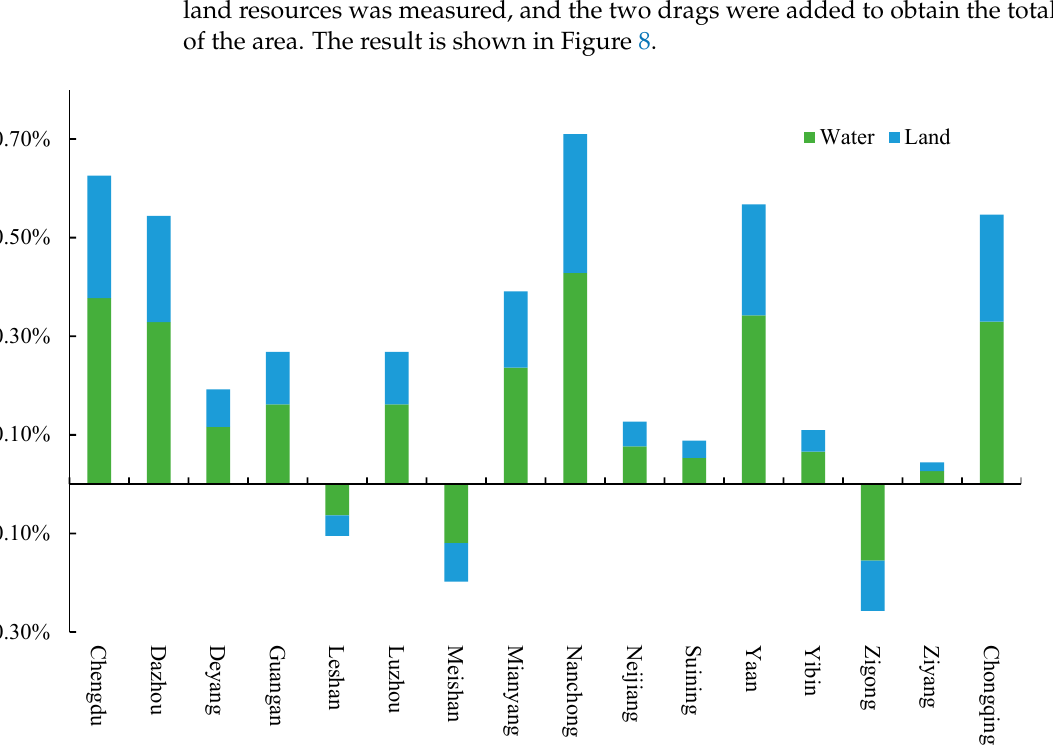
Figure 8. Water and land resources growth drag of cities in Chengdu-Chongqing Economic Circle.